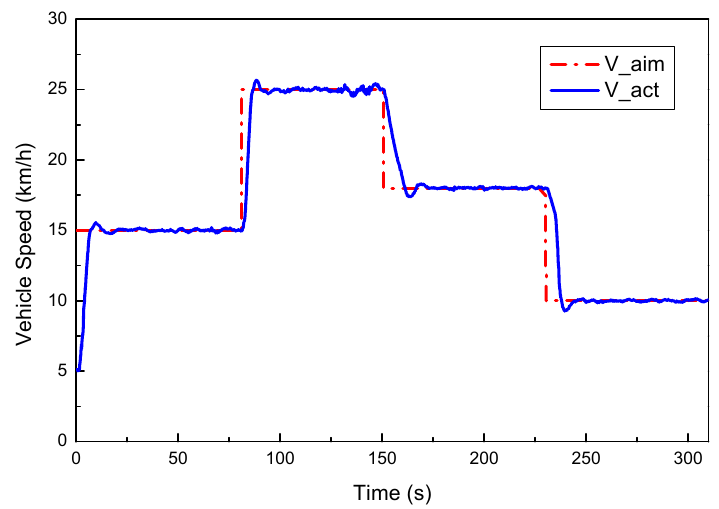
Figure 18. Longitudinal velocity tracking results with stepped set speeds.